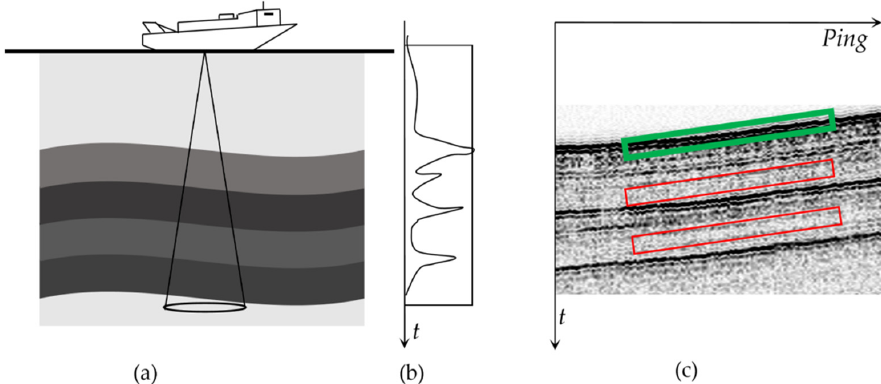
Figure 3. Illustration of sub-bottom profile (SBP) measurement, ( a ) shows that the measurement of the sub-bottom profile can capture the information of sediment, ( b ) shows the received reflection echoes, and ( c ) is the final cross-section image of the sub-bottom. The red rectangles in ( c ) represent the sediment interior and the green rectangle represents the sediment interface.